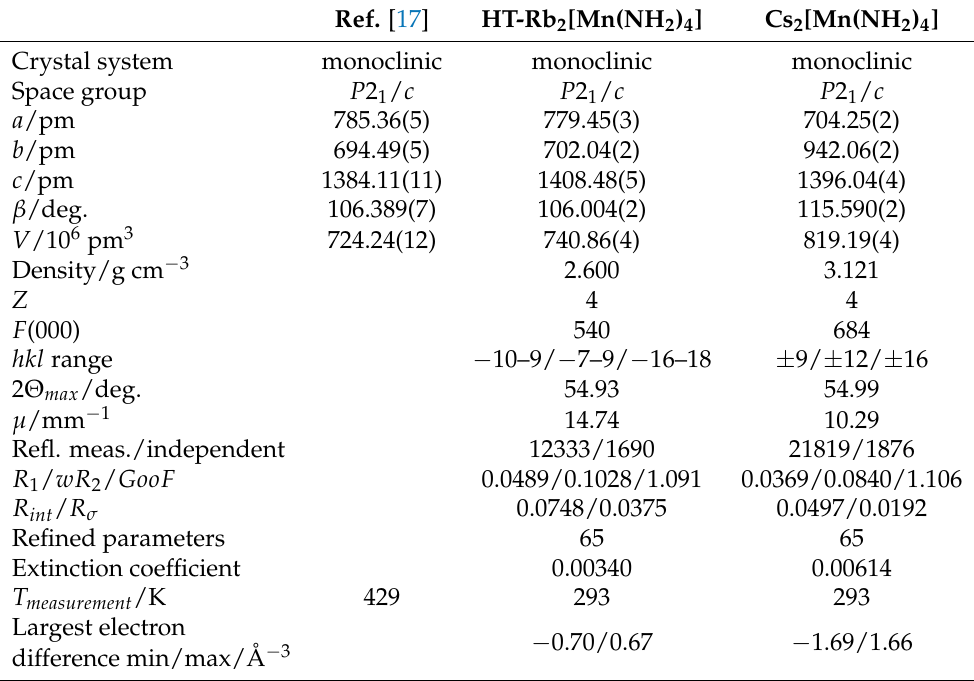
Figure 1. Unit cells of LT-Rb 2 [Mn(NH 2 ) 4 ] ( left ) [17], HT-Rb 2 [Mn(NH 2 ) 4 ] ( middle ) and Cs 2 [Mn(NH 2 ) 4 ] ( right ) with tetraamidomanganate ions shown as polyhedra. Viewing direction is [0¯10]. Table 1. Selected crystallographic data and information concerning structure determination for HT-Rb 2 [Mn(NH 2 ) 4 ] and Cs 2 [Mn(NH 2 ) 4 ] from this work and comparison to literature data for the rubidium compound obtained from ball milling and subsequent phase transition from the respective low-temperature